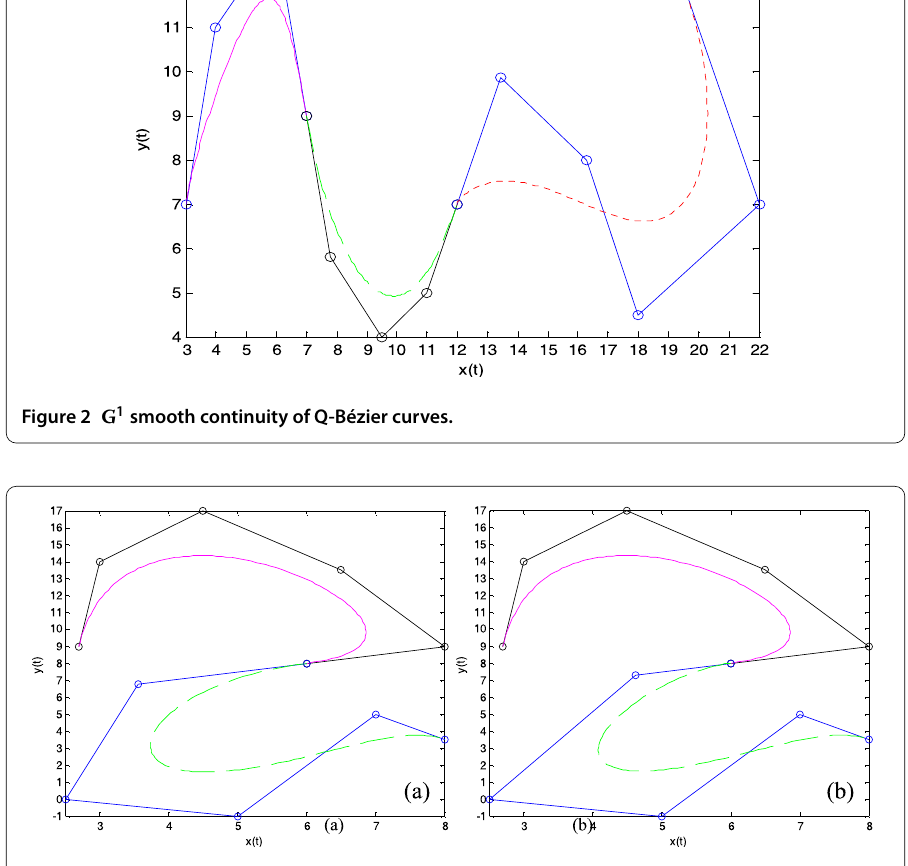
Figure 3 G 1 smooth continuity of quintic Q-Bézier